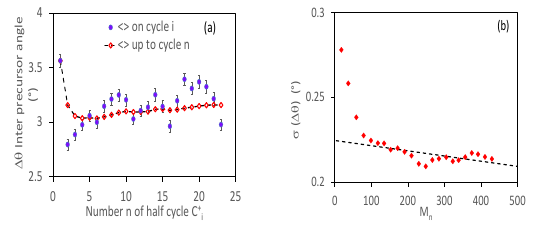
Figure 4. (a) Evolution of the inter-precursor angle ∆ θ averaged ( <> )on each half-cycle C ± (disk with its error bar) and accumu- i lated average from 0 up to n (open diamond) versus the number n up to 23 full-cycles. (b) Evolution of the accumulated data error (cid:80) n + M − bar versus M n = ( M + ) , the dashed line corresponds to i = 1 i i the fit for the latest